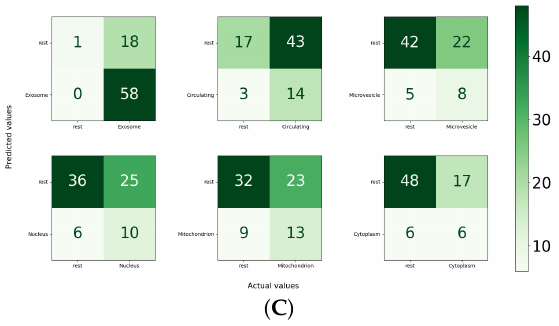
Figure 8. Accuracy confusion matrices of the MirLocPredictor and TextRNN [43] approaches: ( A ) accuracy confusion matrix of the proposed MirLocPredictor approach using the one-versus-all strategy, with MirLocPredictor predictions using 10-fold cross validation; ( B ) accuracy confusion matrix of the TextRNN [43] approach using the one-versus-all strategy, with TextRNN [43] predictions using 10-fold cross validation; and ( C ) accuracy confusion matrix produced by the proposed MirLocPredictor over an independent test set using the one-versus-all strategy, with MirLocPredictor predictions over an independent test